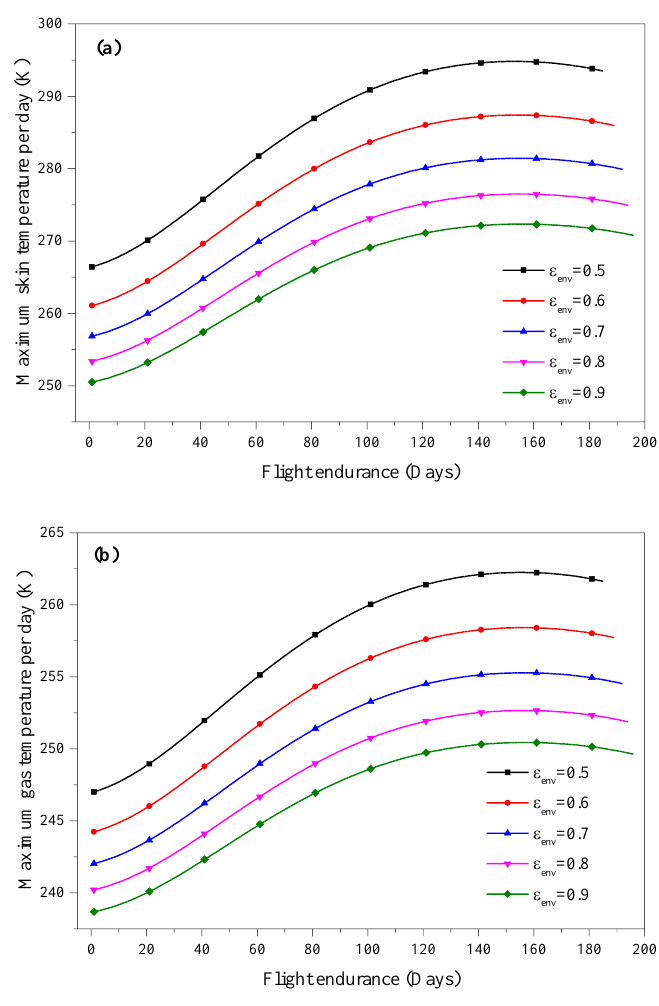
Figure 18. Effects of envelope emissivity on diffusion coefficient.